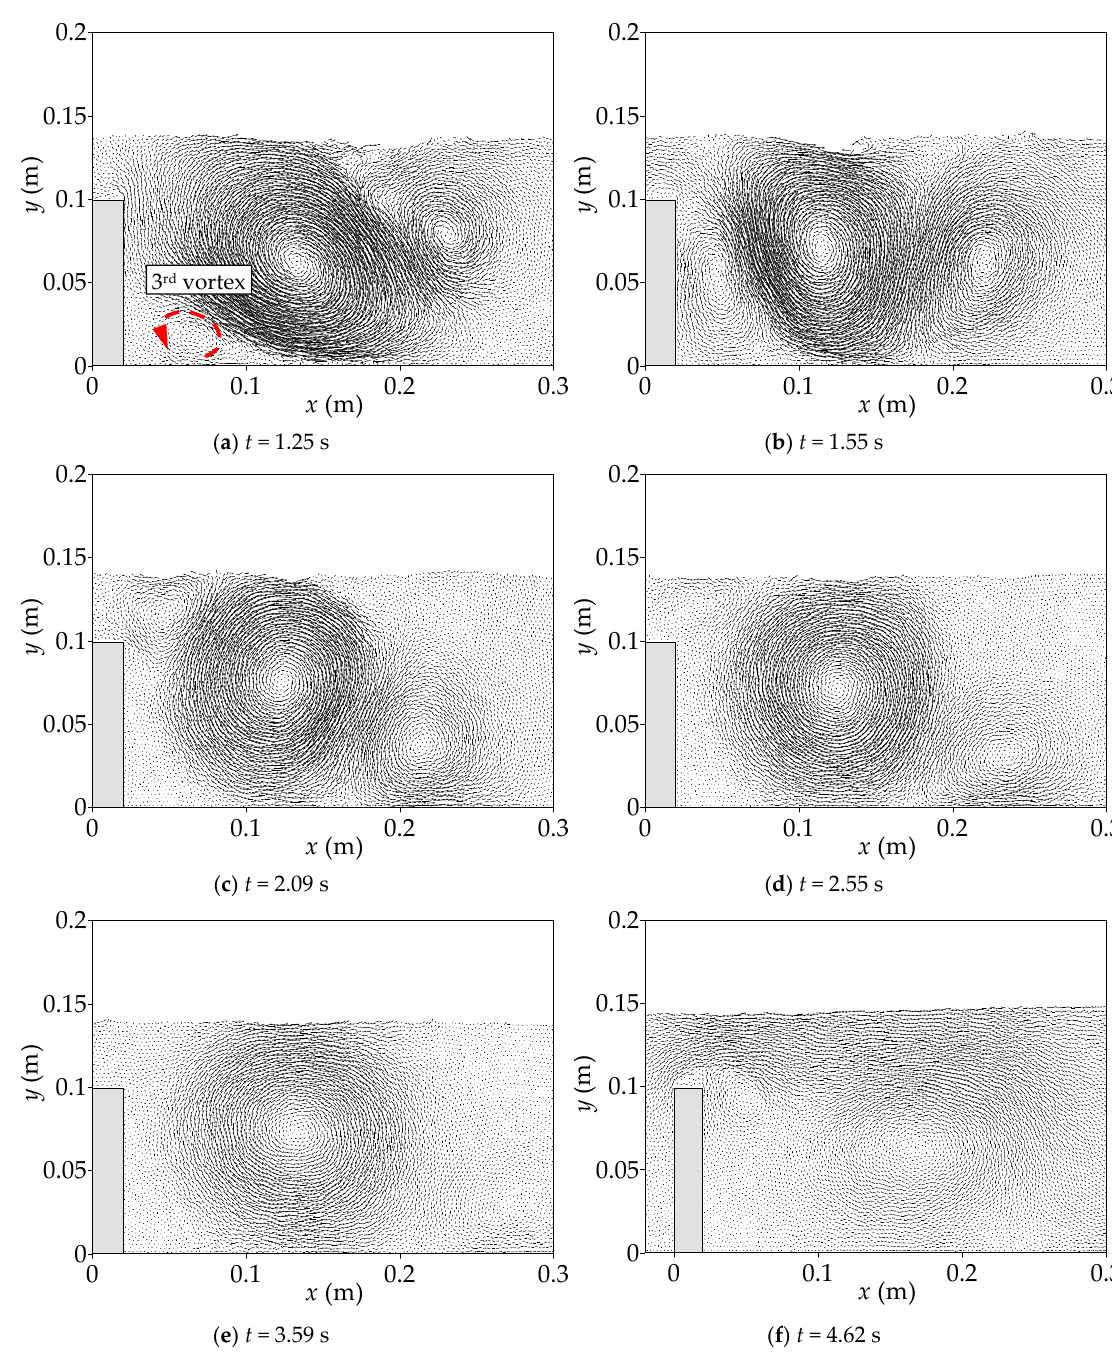
Figure 6. Snapshots of backward plunging breaker and forward jet flow interaction: ( a ) t = 1.25 s; ( b ) t = 1.55 s; ( c ) t = 2.09 s; ( d ) t = 2.55 s; ( e ) t = 3.59 s; ( f ) t = 4.62 s.